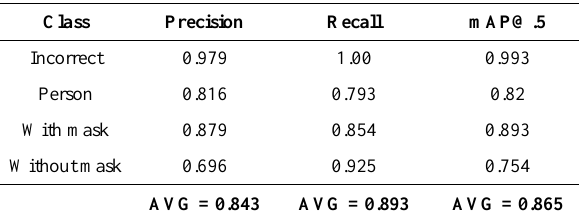
Table 1. Average results for all